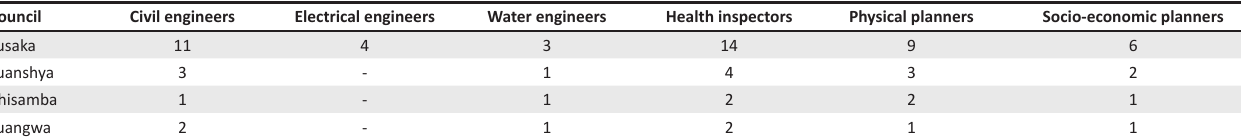
TABLE 5: Number of technical employees.